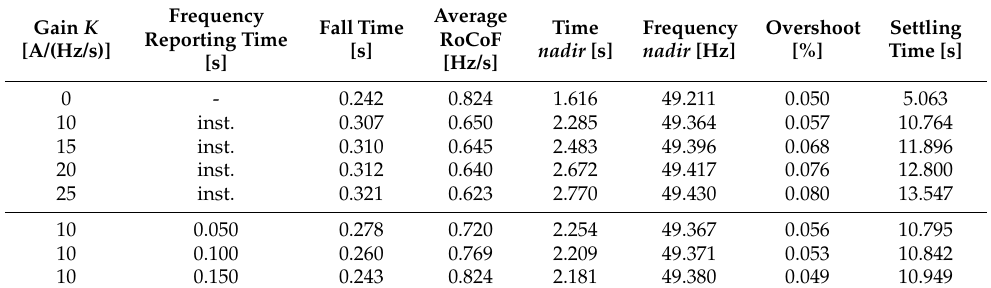
Table 2. Ideal synthetic inertia controller: characteristics of the frequency step